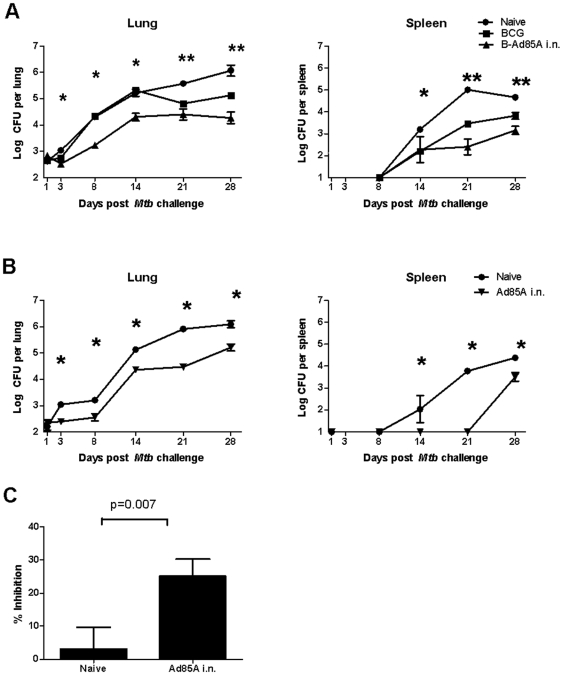
Early control of mycobacterial growth by intranasal administration of Ad85A.BALB/c mice were immunized with BCG or primed with BCG and 10 weeks later boosted with Ad85A i.n. (A) or immunized only with Ad85A i.n. (B) Naïve mice were used as controls. Mice were challenged with Mtb by aerosol 4 weeks after the last immunization and sacrificed at days 1, 3, 8, 14, 21 and 28. Lung and spleen CFU were enumerated. Results are expressed as the mean counts of 5–7 mice per group. * p<0.05 Ad85A or B-Ad85A immunized mice versus Naïve or BCG, **p<0.05 for B-Ad85A versus Naïve, BCG versus B-Ad85A, BCG versus Naïve. Similar results were obtained in a repeat experiment. Standard deviations are small, so that the error bars are within the symbols when not visible. (C) Inhibition of Mtb growth in macrophages by lung cells in vitro. Murine peritoneal macrophages were infected with Mtb and co-cultured with lung cells from naïve mice or mice immunized with Ad85A i.n. 3 weeks previously. Inhibition of mycobacterial growth was determined after 3 days. Results are expressed as the mean % inhibition +/− SEM of four experiments with four mice per group.